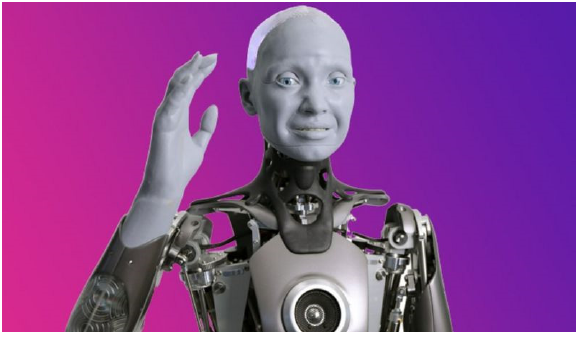
Figure 4. Image of the robot Ameca [9].